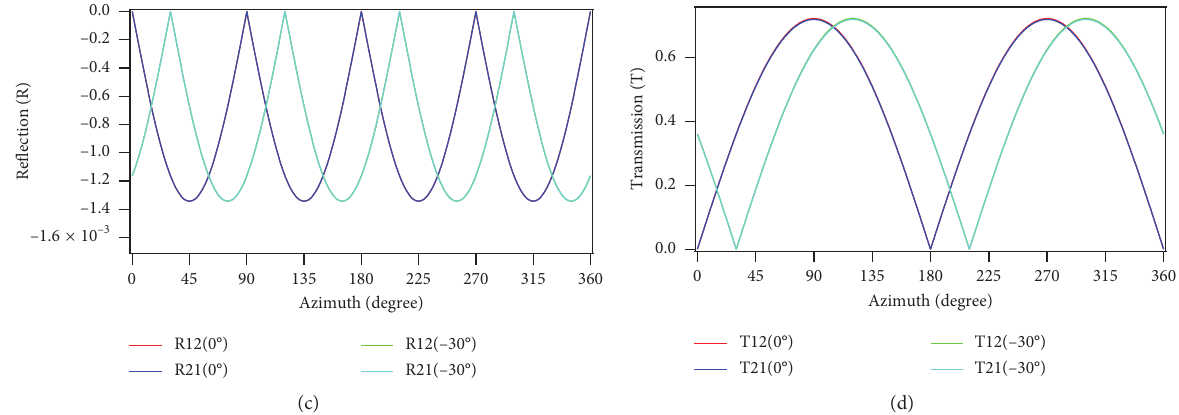
Figure 5: The reflection and transmission coefficients at the interface between free air and anisotropic ice layers are calculated. The difference of azimuth angles in the upper and lower layer is set at φ coordinate rotates from 0 to 2 π .